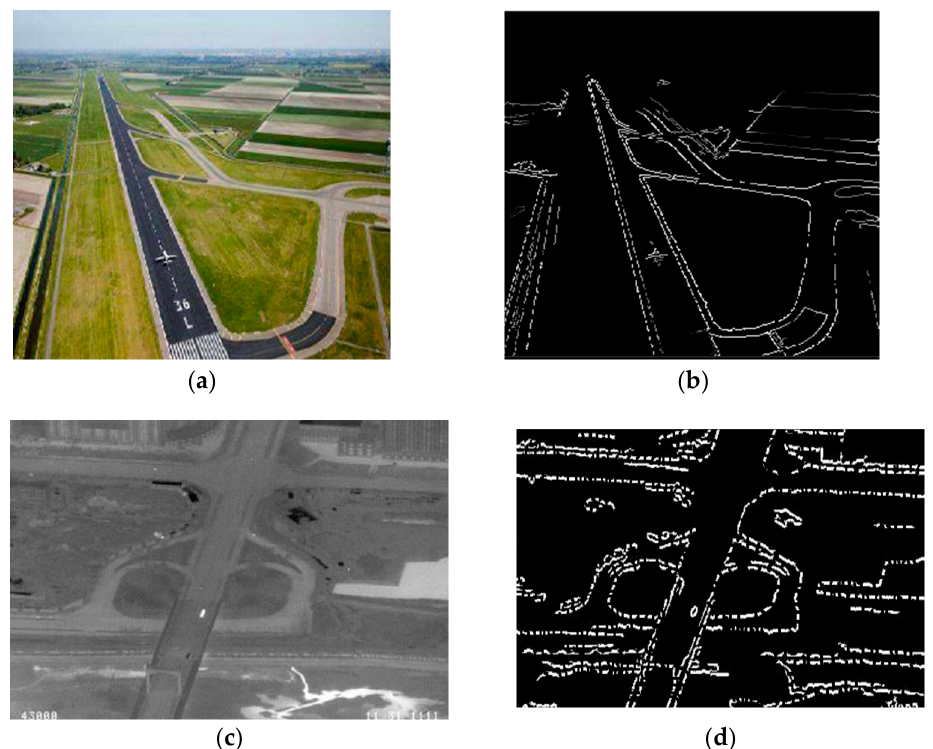
Figure 11. Result of edge detection. ( a ) Original airport image 1; ( b ) the algorithm in this paper airport image; ( c ) original road image 2; ( d ) the algorithm in this paper road image